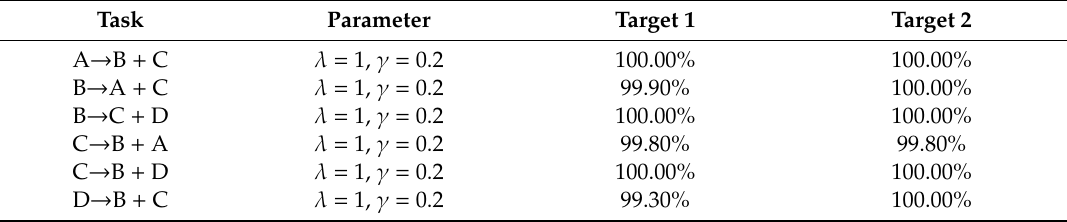
Table 4. The diagnosis accuracy (%) of multi-target domain